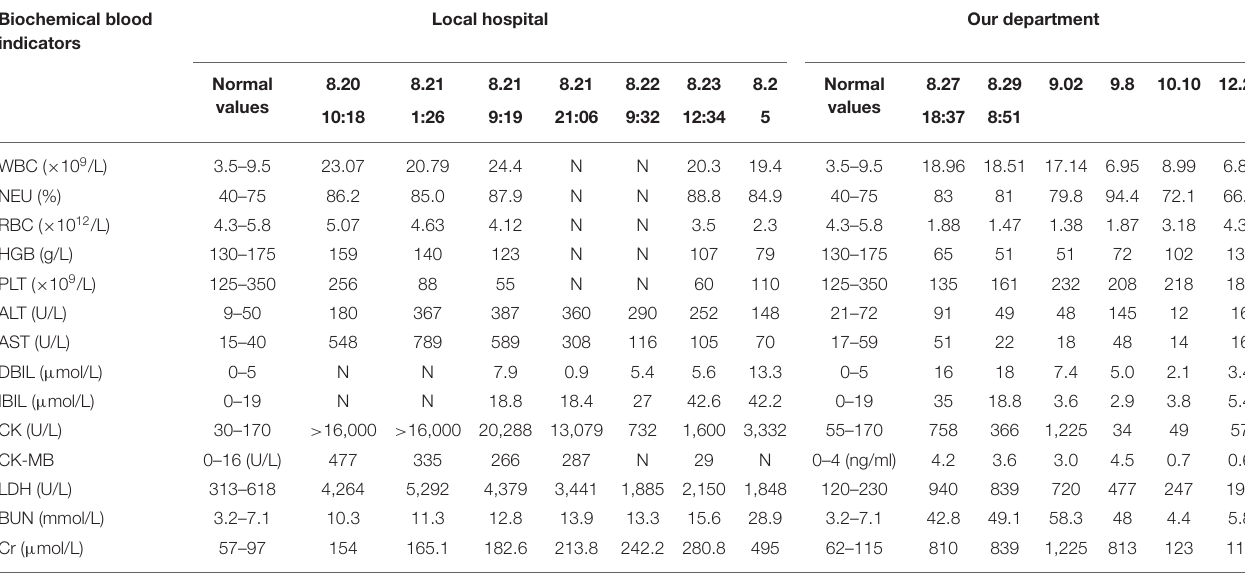
TABLE 1 | Laboratory test results. Biochemical blood